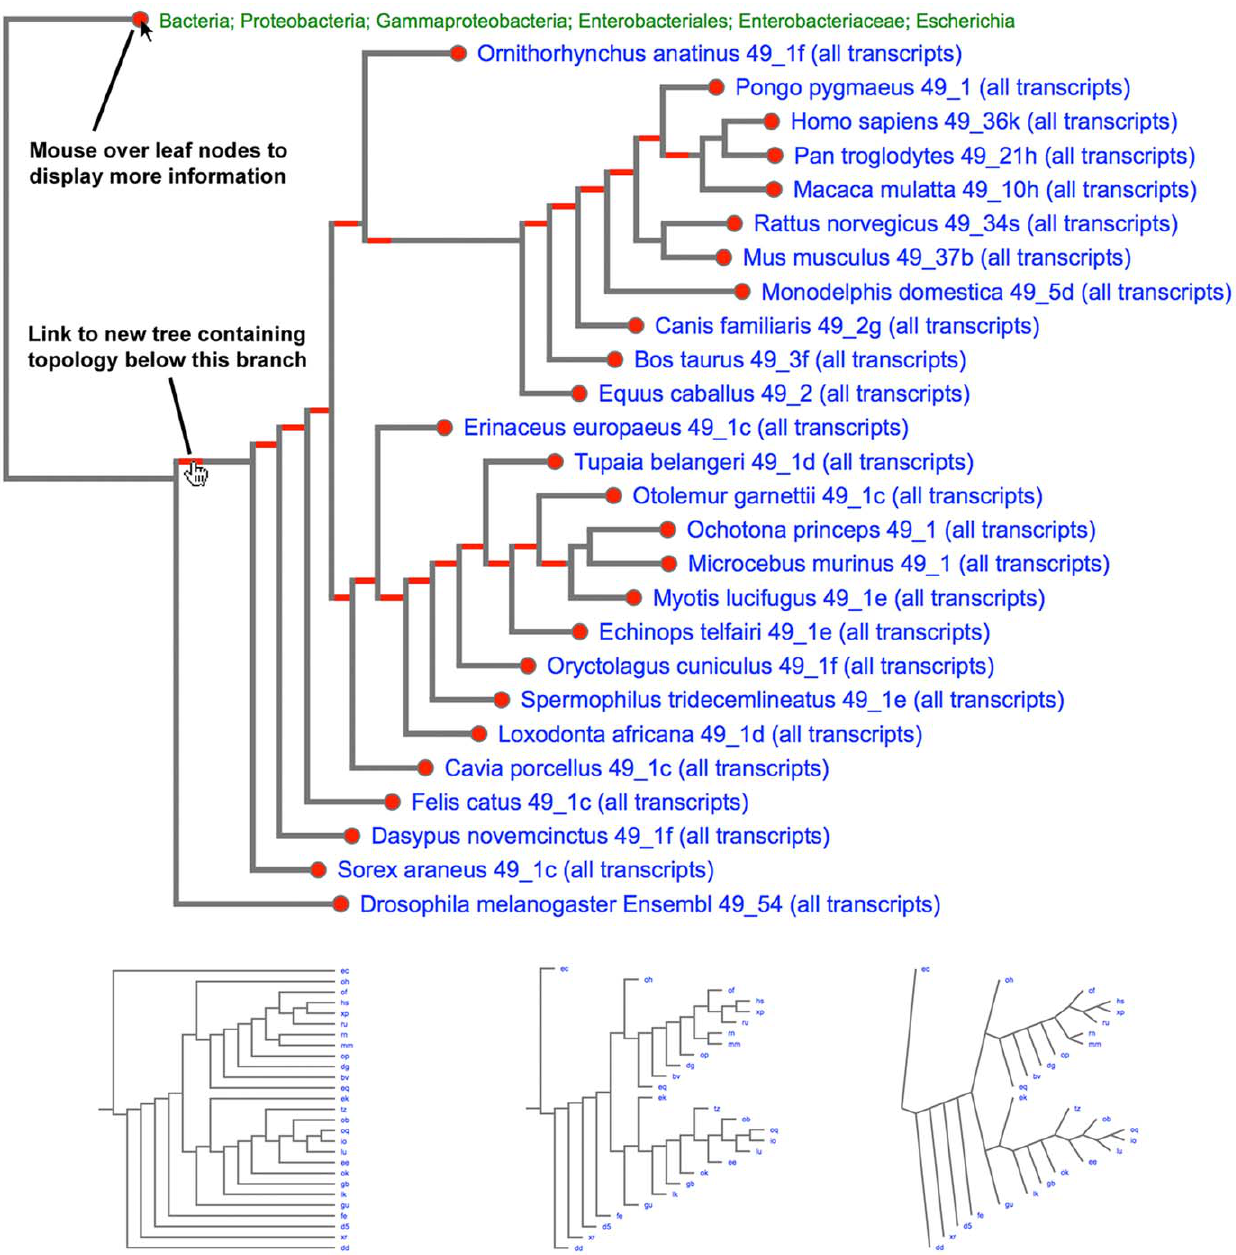
Figure 1. A view of the TreeVector web interface integrated with the SUPERFAMILY server. Interactive features of TreeVector are shown in Figure 1. Moving the mouse over the red circles displays extended information, such as taxonomy instead of organism name. Red links in branches can be used to display a tree containing only the nodes below this branch. The blue leaf labels link to the relevant genome pages on SUPERFAMILY. Also shown are some of the other formats of tree output available, such as triangular branches and aligned labels.